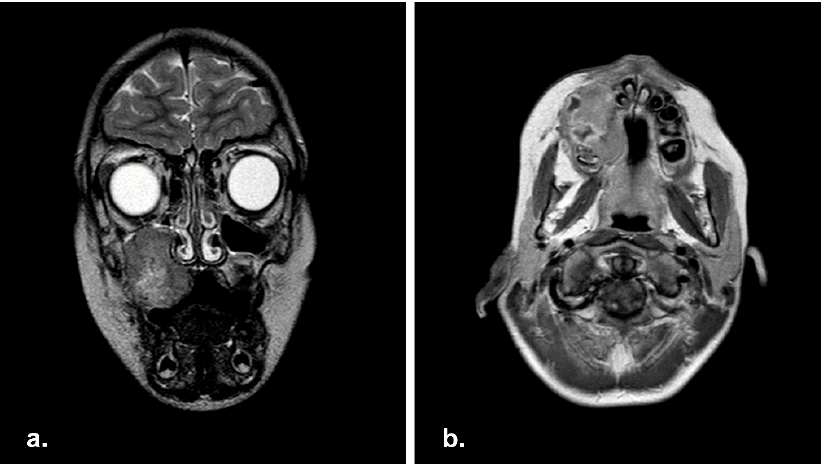
Figure 1. Pre-operative Magnetic Resonance Imaging (MRI) in coronal ( a ) and axial ( b ) view showing a well-demarcated mass in right maxillary sinus with extension in the right hard palate.